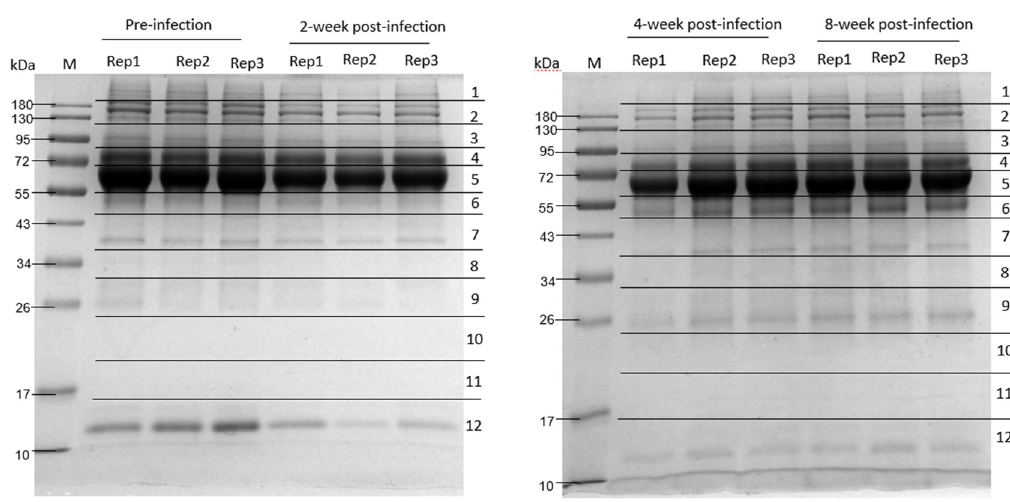
Fig 1. SDS-PAGE of T . spiralis uninfected and infected mouse sera. Lanes (from left to right): marker, uninfected, 2, 4 and 8 weeks post infection. The 11 horizontal sections show the regions excised for MS analyses.